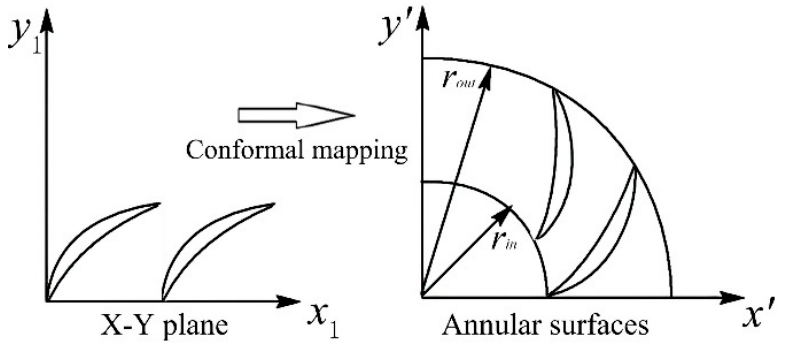
Figure 10. Schematic of conformal mapping.